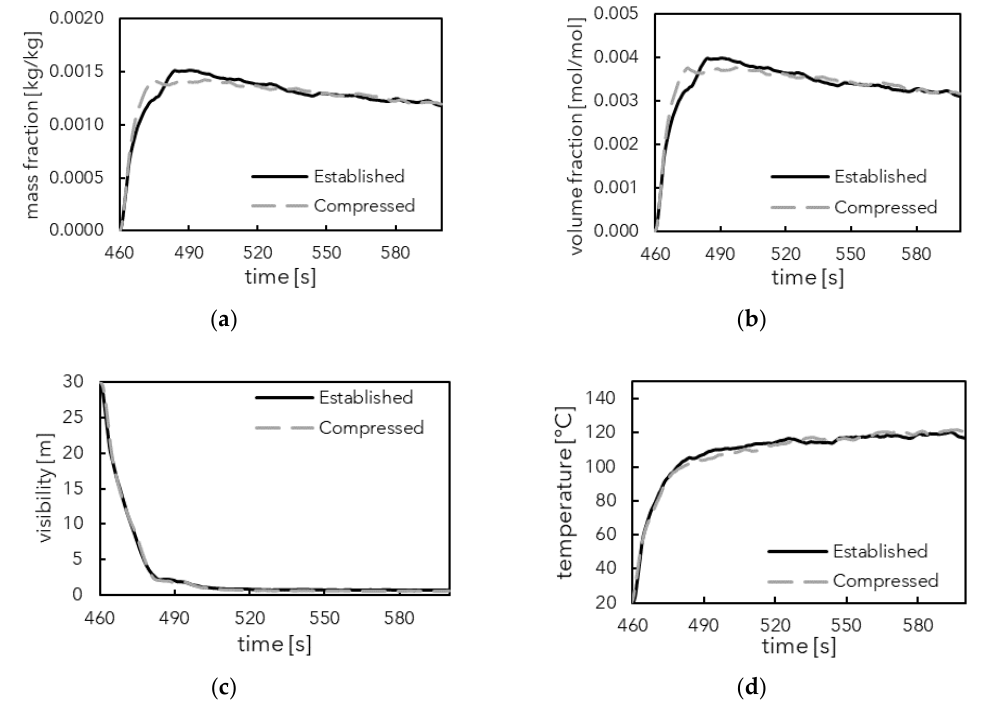
Figure 10. Results for the firefighting phase, spatially-averaged for the full corridor volume: ( a ) soot mass fraction; ( b ) soot volume fraction; ( c ) visibility; and ( d ) temperature.